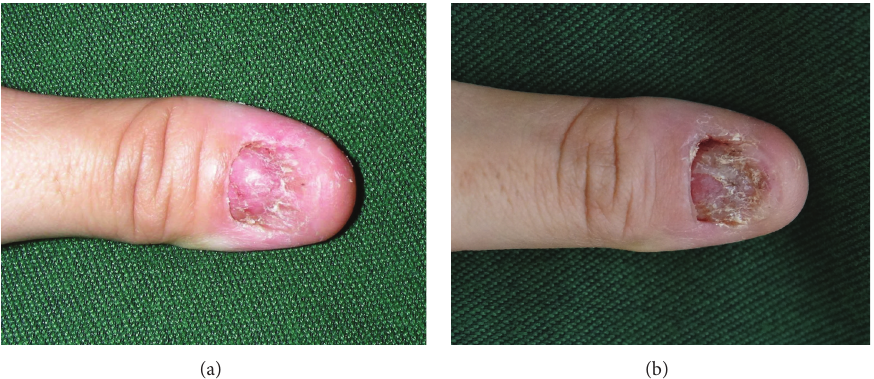
Figure 1: Left thumbnail five months after nail loss, at the first visit to our hospital (a) and 10 months after nail loss (b).